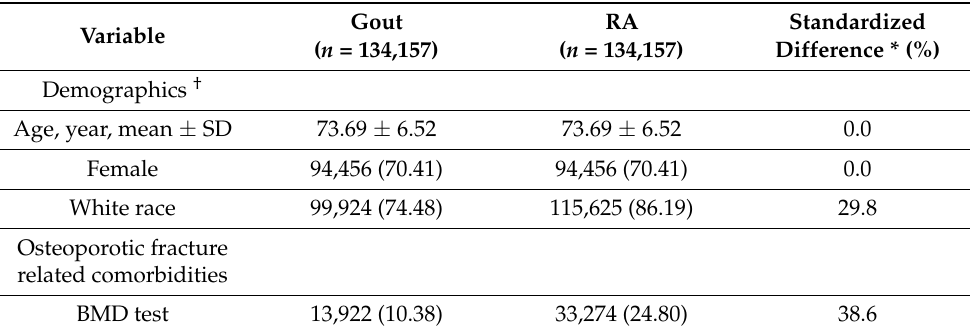
Table 1. Baseline characteristics of study populations in the 365 days before study